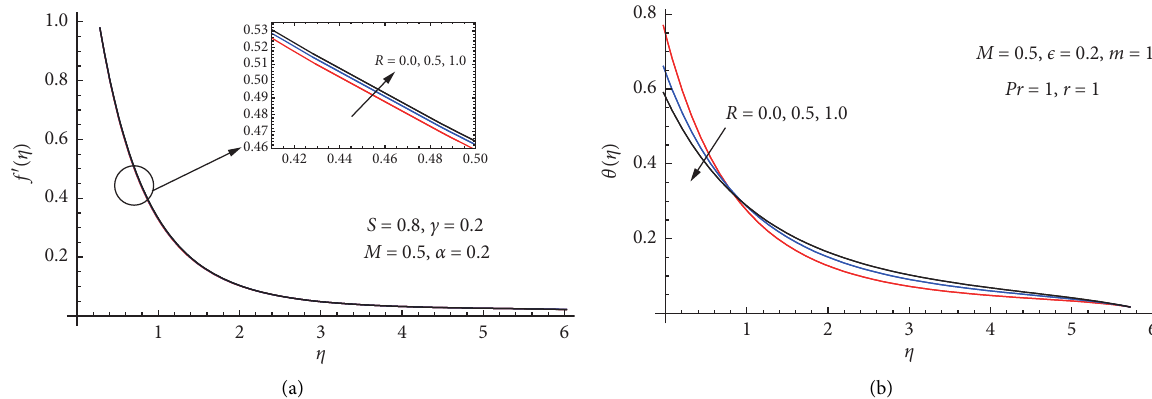
Figure 3: (a) Velocity distribution for R . (b) Temperature distribution for R